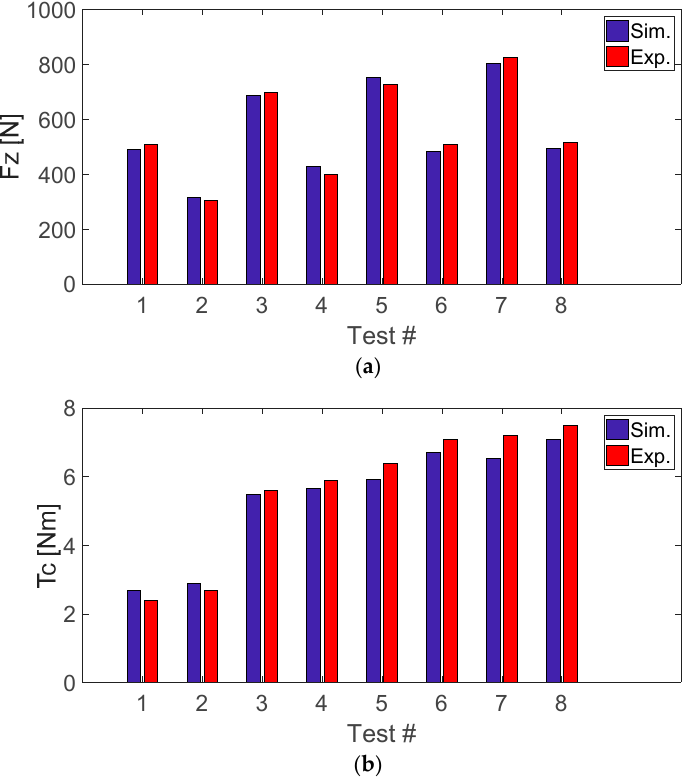
Figure 9. Model validation for F z ( a ) and T c ( b ) magnitudes.